Question: Describe this figure in one sentence.
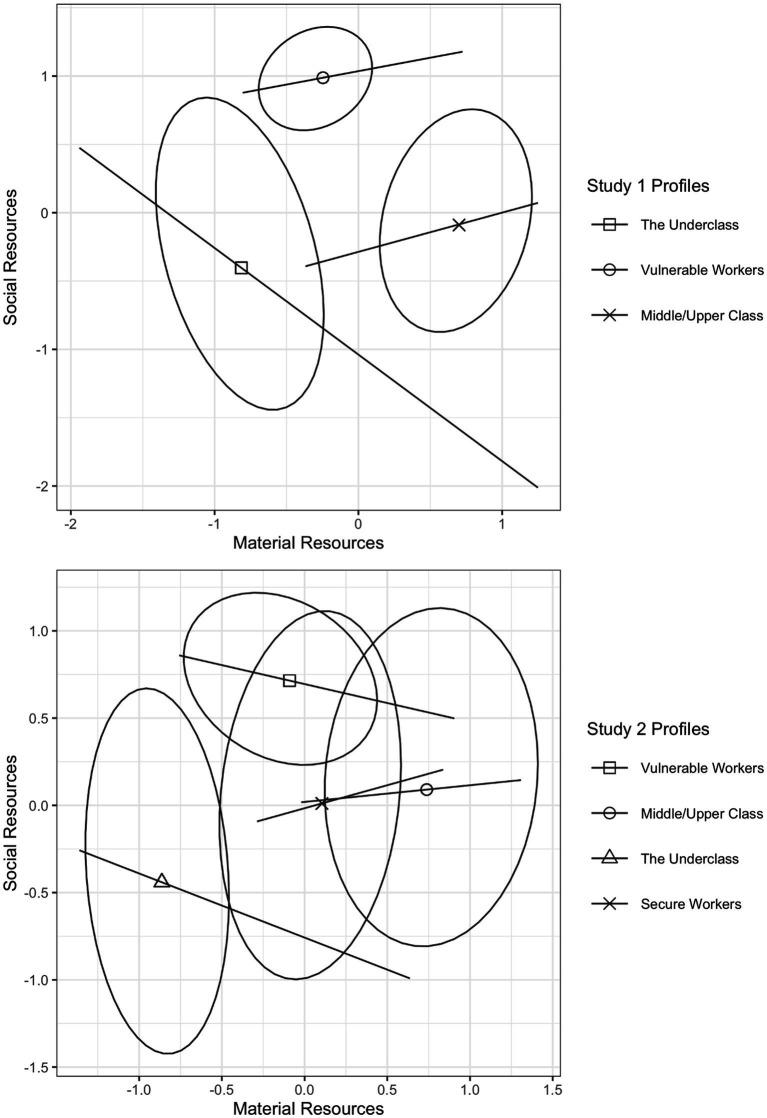
Answer: Social-class profile means and within-profile associations between material resources and social support in studies 1–2.